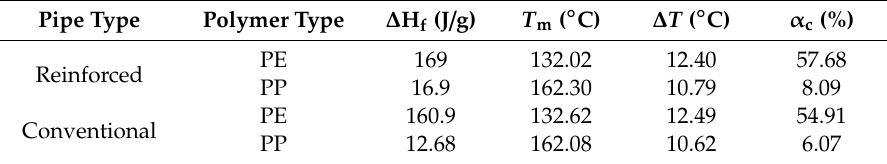
Figure 5. The second heating DSC curves for the SGF/HDPE/PP pipe. Table 1. The second heating DSC testing results of the SGF / HDPE / PP